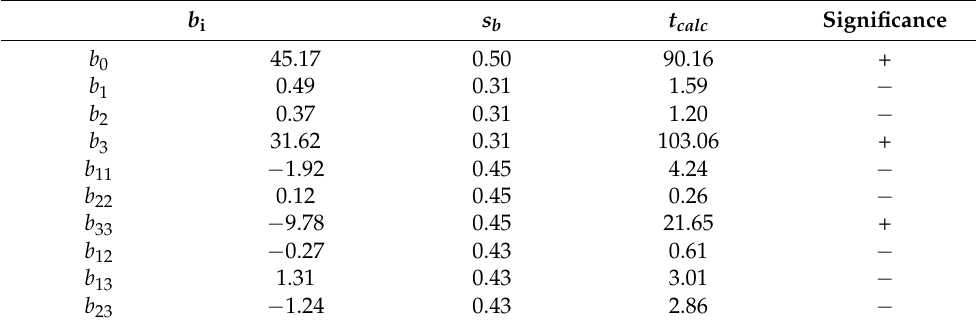
Table 7. The coefficients of polynomials found for T g and significance.